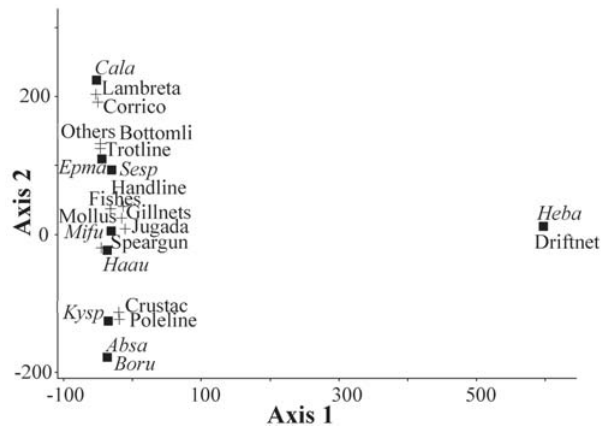
Fig. 2. Ordination plots of the correspondence analysis (first two axes) based on fishermen answers about fishing methods and baits of the nine studied fish species in the southeastern Brazilian coast: Absa = Abudefduf saxatilis ; Boru = Bodianus rufus ; Cala = Caranx latus ; Epma = Epinephelus marginatus ; Haau = Haemulon aurolineatum ; Heba = Hemiramphus balao ; Kysp = Kyphosus spp.; Mifu = Micropogonias furnieri ; Sesp = Seriola